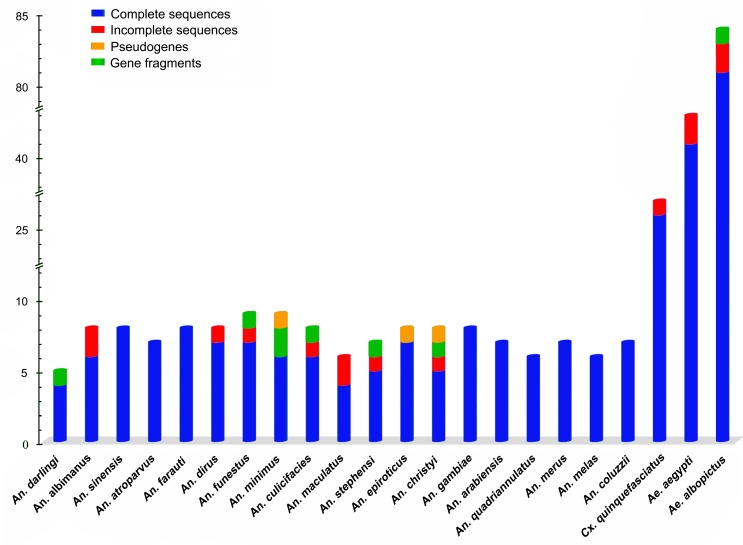
Numbers of CSP genes in the 22 mosquito species investigated.Gene numbers include complete, incomplete, and gene fragments as well as pseudogenes. Genes with complete and incomplete sequences are considered putatively functional CSP genes. Gene fragments sequences and pseudogenes are not used in further analysis.